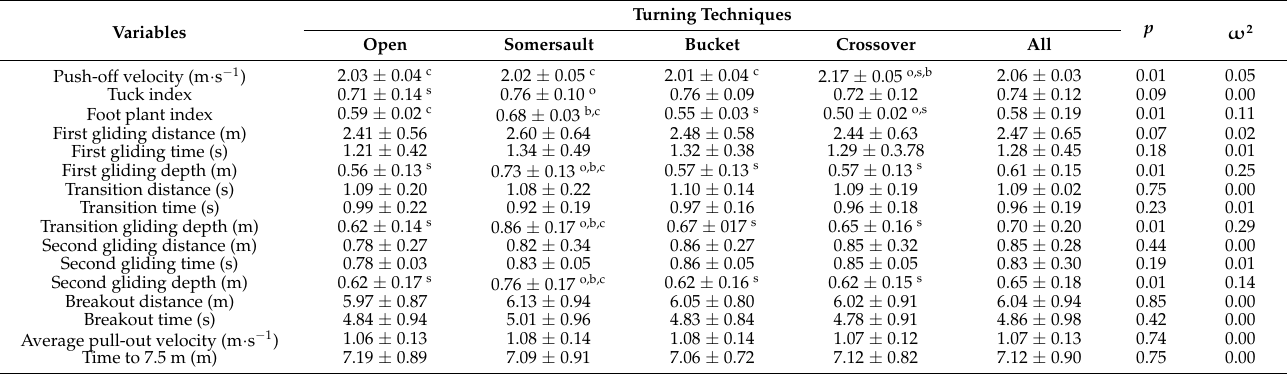
Table 3. Mean ± SD values, p values and effect sizes regarding the kinematics and pull-out variables of four turning techniques of the backstroke-to-breaststroke